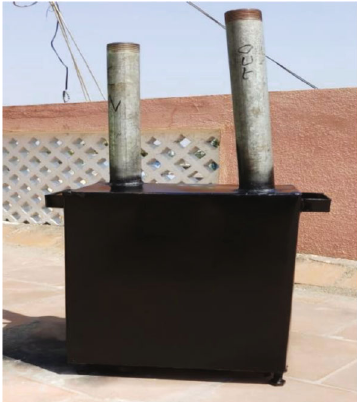
Figure 5: The image of fabricated of CO